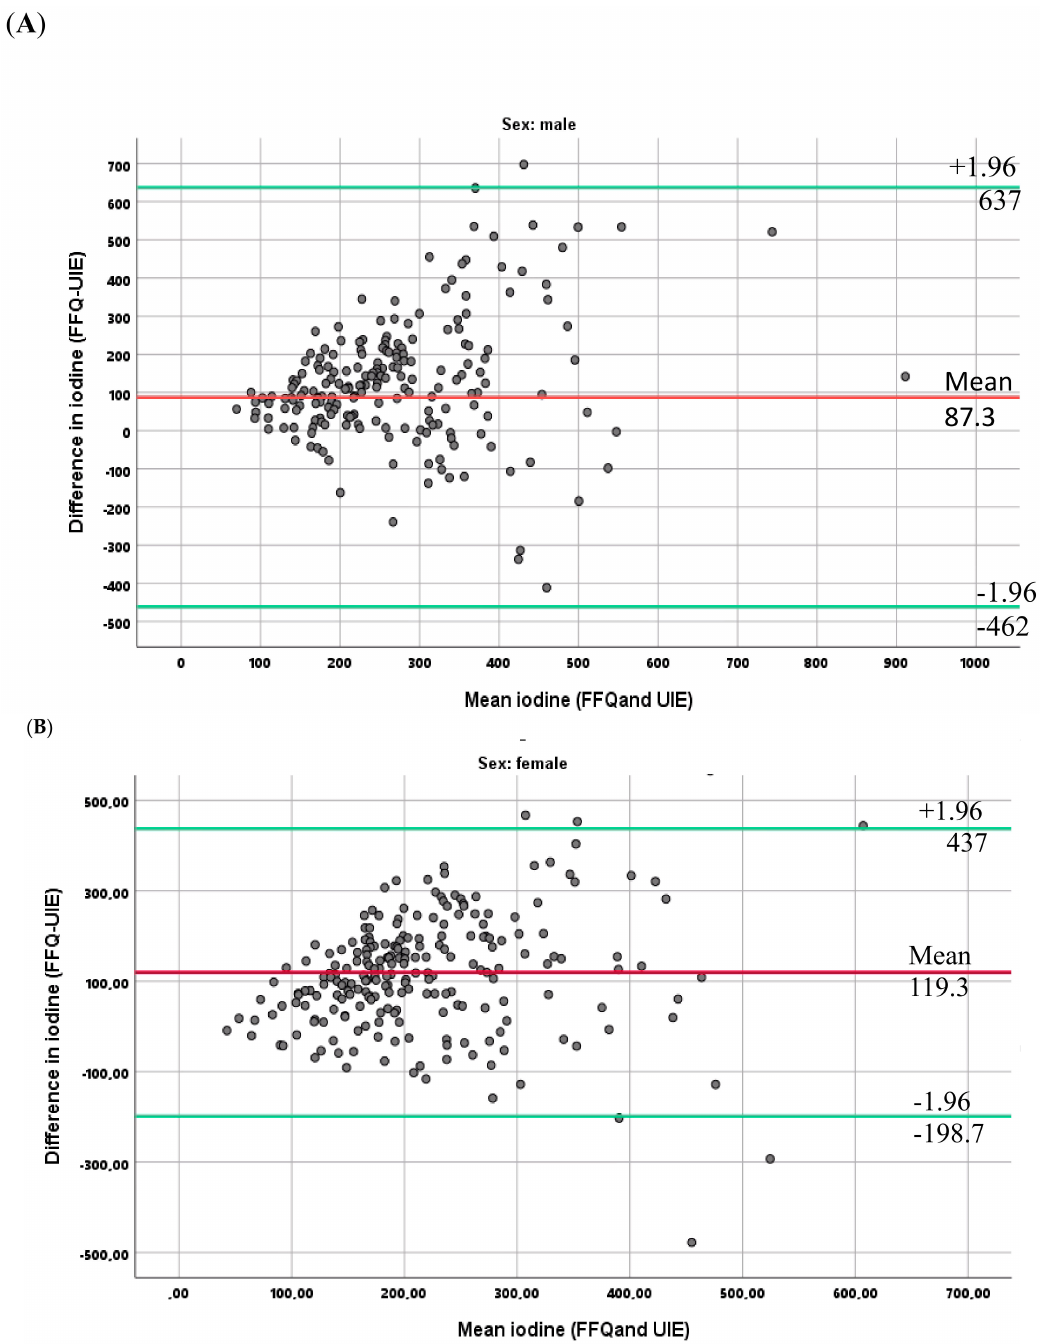
Figure 1. Bland–Altman plot, mean iodine intake estimated from 24 h-urine and the FFQ versus the di ff erence between the methods (FFQ-UIE), in men ( A ) and women ( B ), The vertical line indicates mean di ff erence in iodine intake estimates (red line), with the representation of the limits of agreement (green lines), from − 1.96 SD to + 1.96